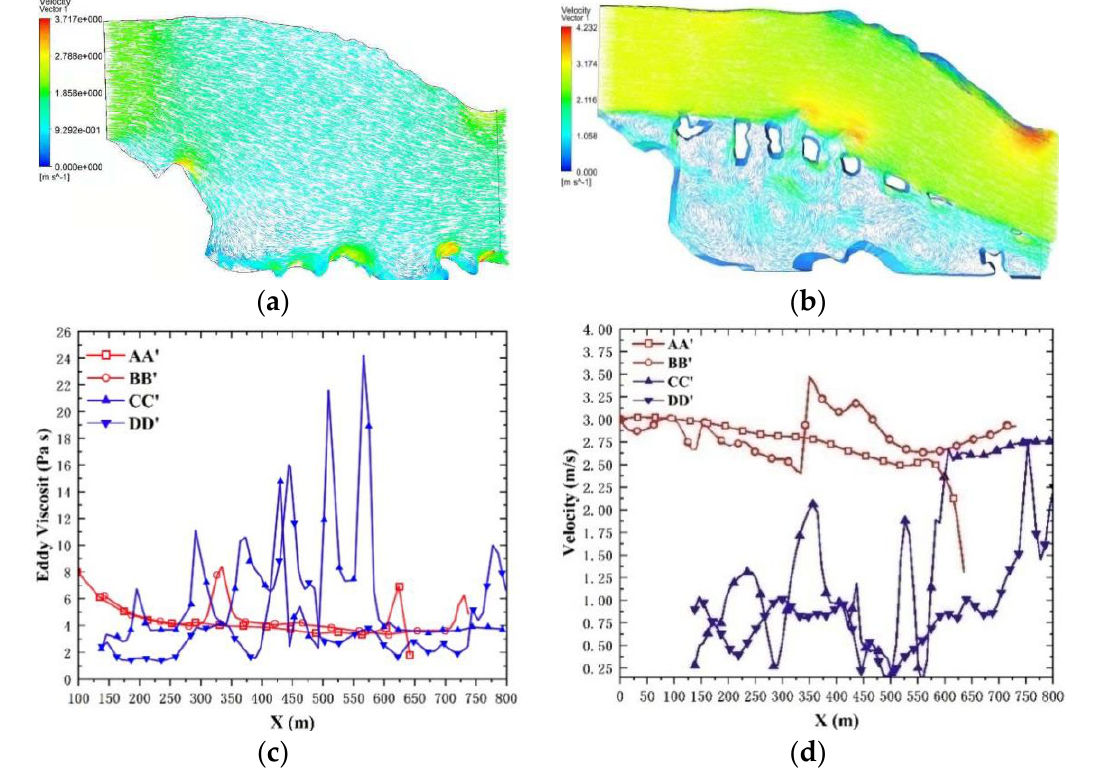
Figure 4. The variation performance of gravel bar construction on the flow conditions and hydraulic morphology heterogeneity in the fish habitat restoration project. ( a ) Nephogram of flow velocity before the implementation of the project. The inflow velocity was set as v 0 = 3.0 m/s. ( b ) Nephogram of flow velocity at inflow velocities v 0 = 3.0 m/s after the implementation of the project. ( c ) Changes in turbulent viscosity at inflow velocities v 0 = 3.0 m/s. The variation in turbulent viscosity at the intersection of AA (cid:48) , BB (cid:48) , CC (cid:48) , DD (cid:48) and the water surface was analysed to compare the turbulence characteristics of Area I and Area II. ( d ) Velocity distributions of the flow field on cross-sections at inflow velocities v 0 = 3.0 m/s. AA (cid:48) and BB (cid:48) represent the current velocities at the water surface in Area II, while CC’ and DD’ represent those in Area I. All simulations were conducted with the inflow velocities of v 0 = 2.0 m/s, v 0 = 3.0 m/s, v 0 = 4.0 m/s, and v 0 = 5.0 m/s, respectively. This figure shows the representative results when the inflow velocity was set at v 0 = 3.0 m/s. Full details of the other results are presented in the Supplementary Material (see Supplementary Figures